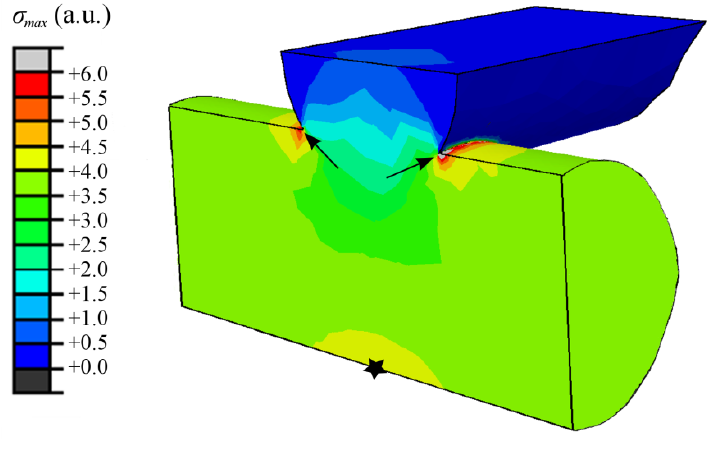
Figure 7. FEM-generated stress contours corresponding to the maximum tensile stress σ at the external surfaces of TCP lowermost rods during 4-point bending test on a bare max TCP